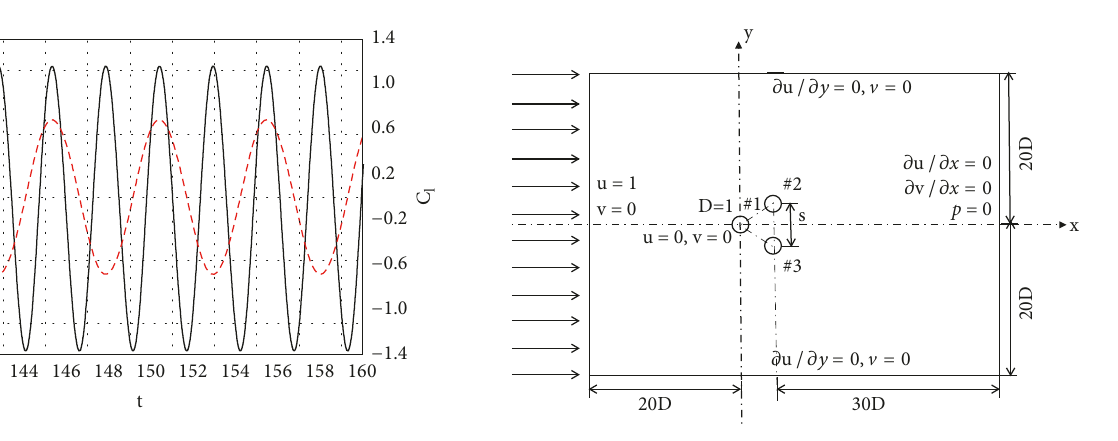
Figure 11: The computation domain and boundary conditions of the flow around three circular cylinders.